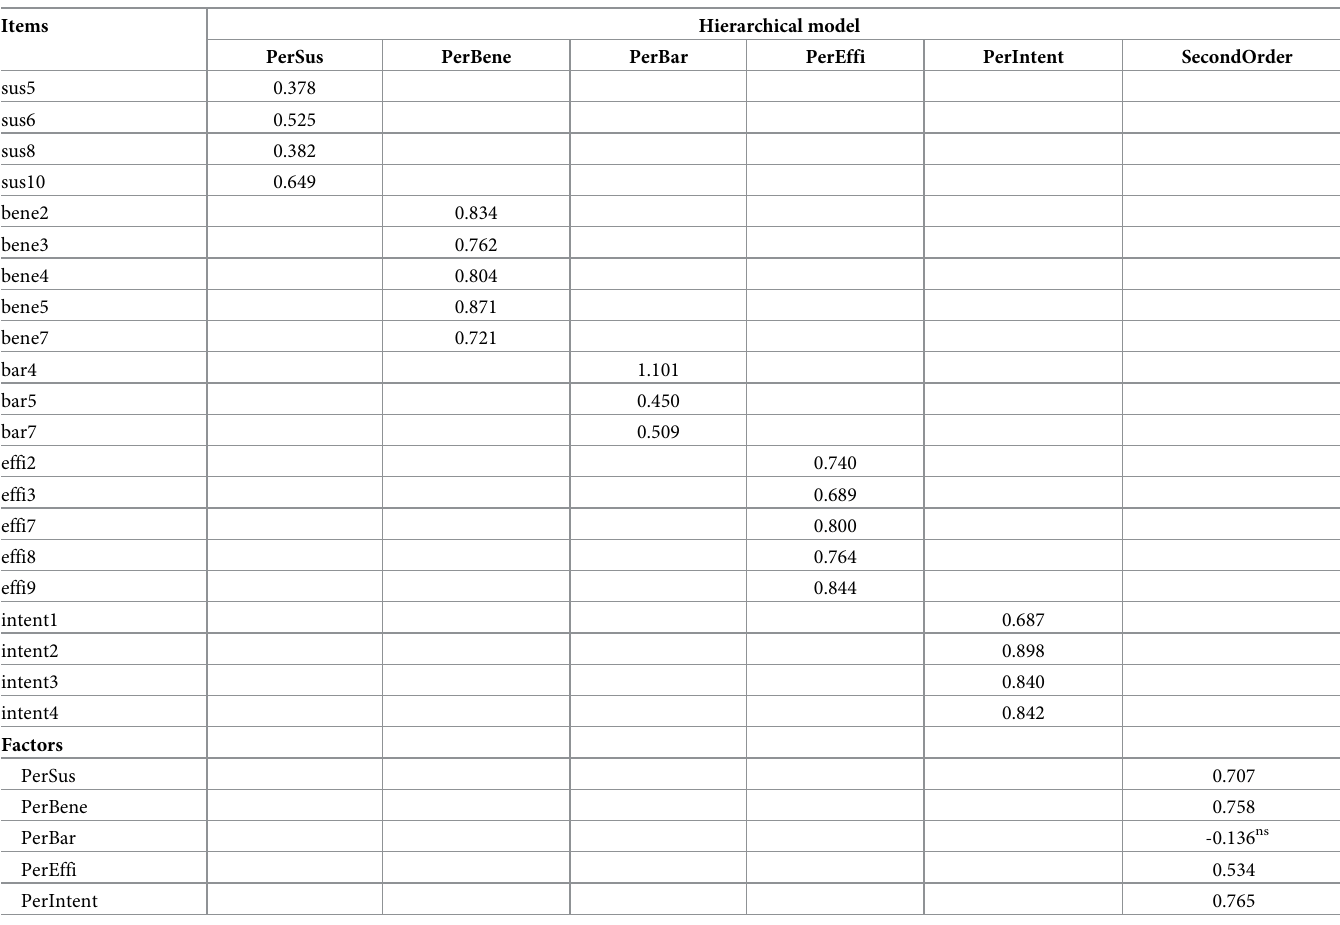
Table 5. Standardized factor loadings of CFA for hierarchical